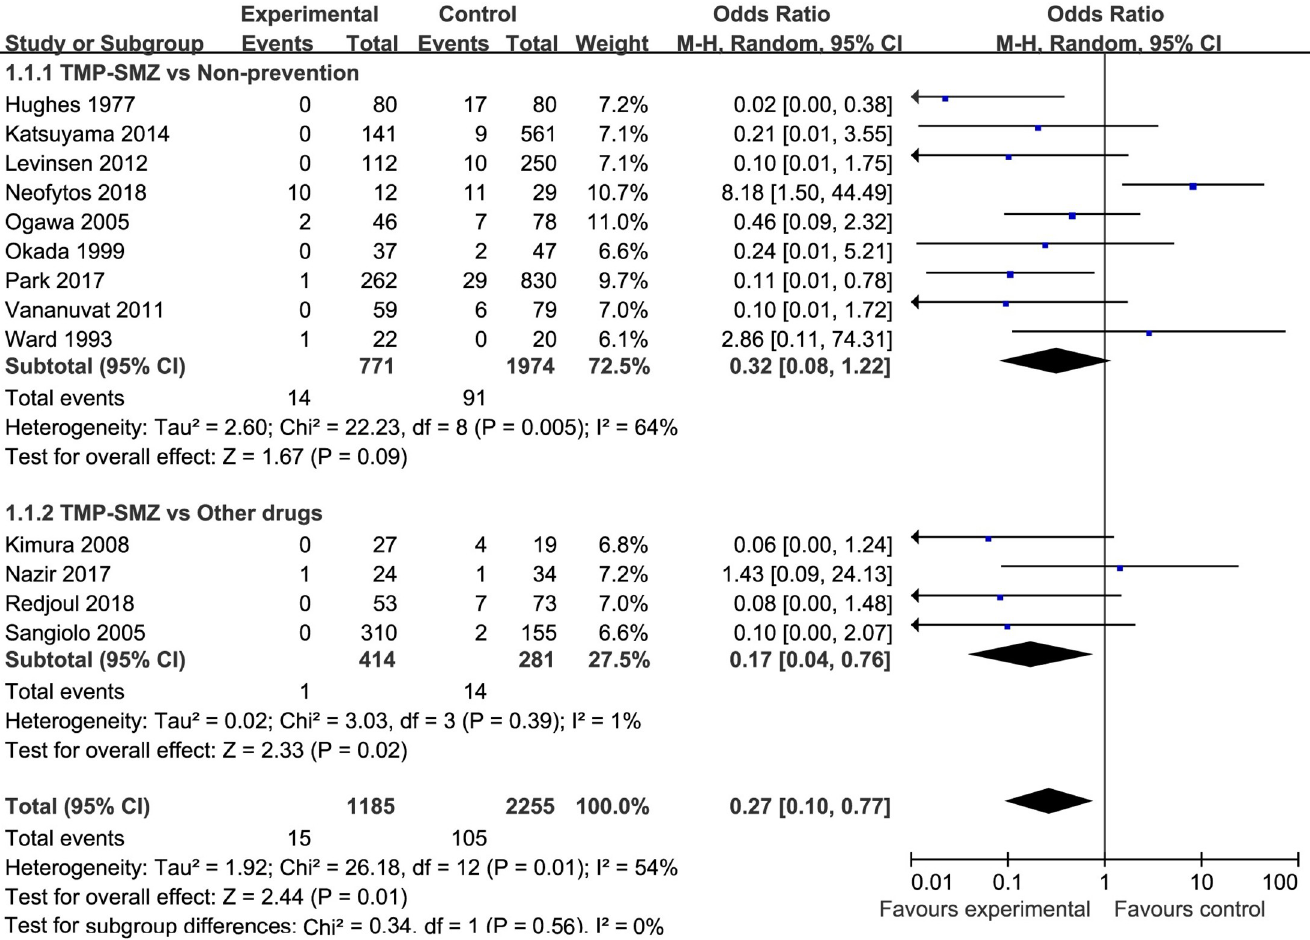
Fig 2. Forest plot of the incidence rate of PCP incidence. The vertical line indicates no difference between the groups. ORs are represented by diamonds, and 95% CIs are depicted by horizontal lines. Squares indicate point estimates, and the size of each square indicates the weight of the given study in the meta-analysis. M-H, Mantel- Haenszel random-effects